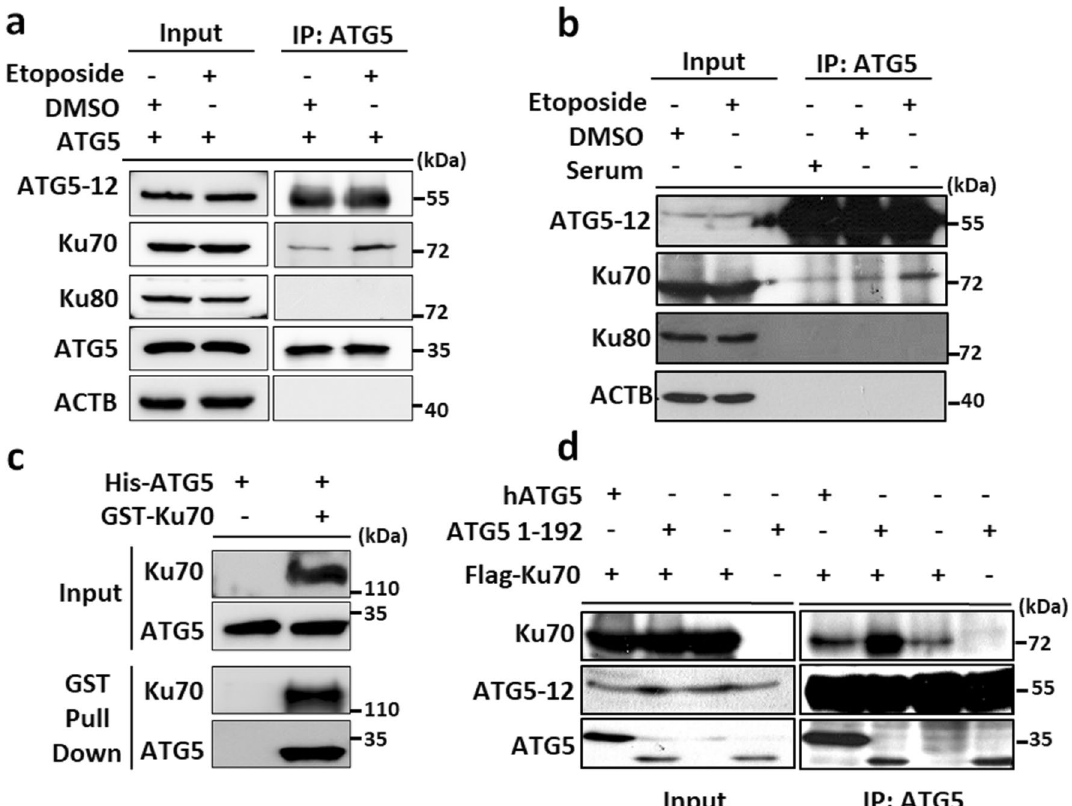
Figure 2. ATG5 endogenously interacts with Ku70. ( a ) HEK293T cells were transfected with plasmids encoding non-tagged ATG5. Cells were exposed to either Etoposide or DMSO, as a vehicle, and IPs were performed with the anti-ATG5 antibody at 48 h post-transfection. ( b ) Endogenous IPs were performed from HEK293T cells treated with Etoposide for along 24 h. DMSO was used as a vehicle. Rabbit serum was used as a stickiness control. ( c ) GST Pull-down assay was performed. Glutathione-Sepharose beads were bound to GST-Ku70 recombinant protein or not incubated with His-ATG5 recombinant protein and washed (Input: Immunoblotting of recombinant proteins; GST-pull down: proteins following pull-down). ( d ) HEK293T cells were co-transfected with plasmids encoding FLAG-tagged Ku70 and/or non-tagged full-length ATG5 or plasmid encoding 1–192 a.a. of ATG5 proteins. Cells were exposed to either Etoposide or DMSO as a vehicle after 24 h post-transfection and IPs were performed using Flag beads. Anti-ATG5, anti-Ku70, anti-Ku80 and anti-FLAG antibodies were used for immunoblotting. Input, total cell extract. ACTB, anti-β-Actin was used as a loading